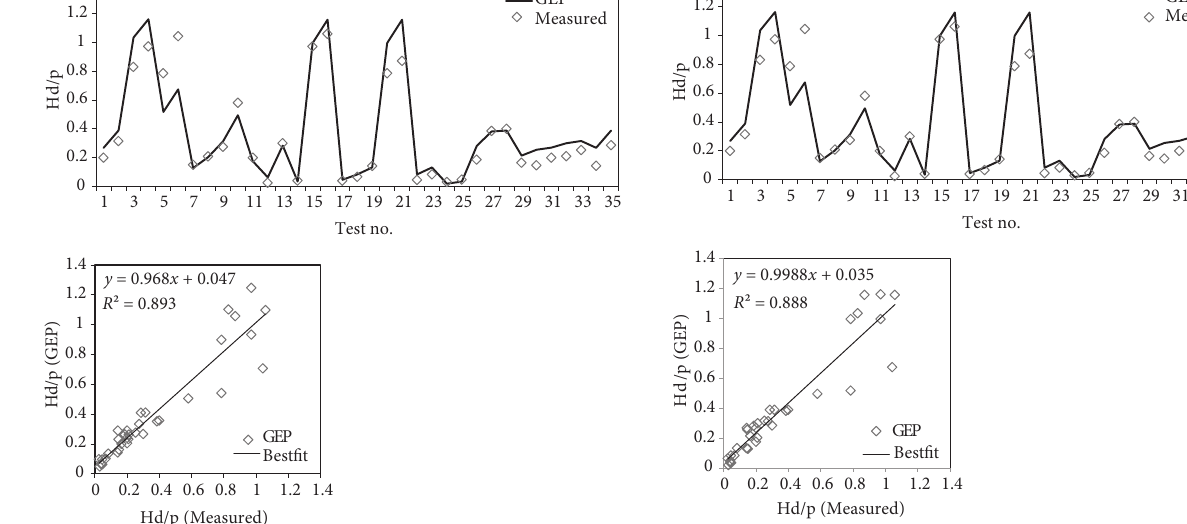
Fig. 10. GEP estimations of H set (model 2)